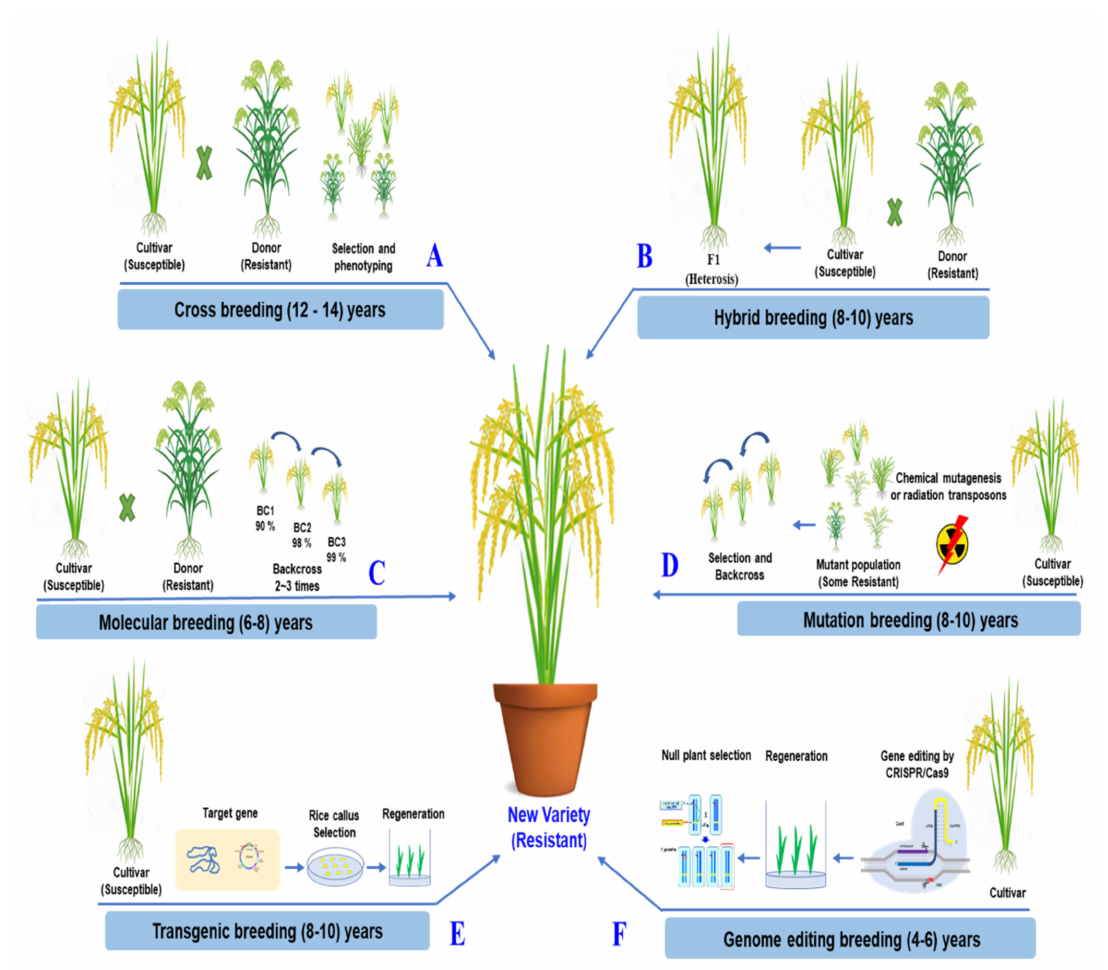
Figure 4. Comparison of the traditional breeding and the modern breeding methods for rice im- provement. ( A ) Crossbreeding based on naturally occurring mutations has introduced various traits into elite recipient lines selected by phenotype, free of transgene. ( B ) Through hybrid breeding, two genetically different parent lines are produced. The heterosis effect is maintained for only one generation, free of transgene. ( C ) Through molecular breeding, various traits are introduced into elite lines, followed by backcrossing, selectinon by phenotype, and molecular marker, free of transgene. ( D ) Throught mutation breeding, radiation and chemical mutagenesis is used to induce random mutations genome-wide. It greatly expands genetic variations. It requires backcrossing. It is free of transgene. ( E ) Transgenic breeding introduces genes or traits from other organisms. Foreign DNA is randomly integrated into the rice genome (GMO). ( F ) Genome editing breeding technologies can modify plant genomes to improve traits without integrating foreign DNA into the genome. The genome is mutated by NHEJ and HDR pathways, free of transgenes. They are precise techniques for future plant